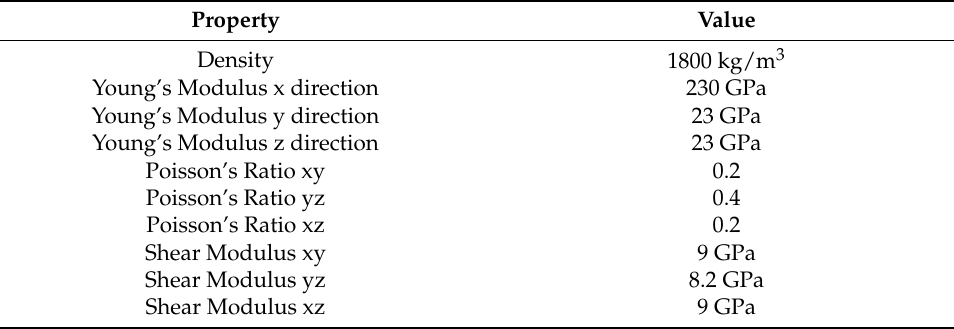
Figure 7. Tensile test simulation with Ansys: ( a ) undamaged laminate, ( b ) damaged laminate, and ( c ) axonometric view of the damaged laminate. Table 1. The physical properties of the material used in the